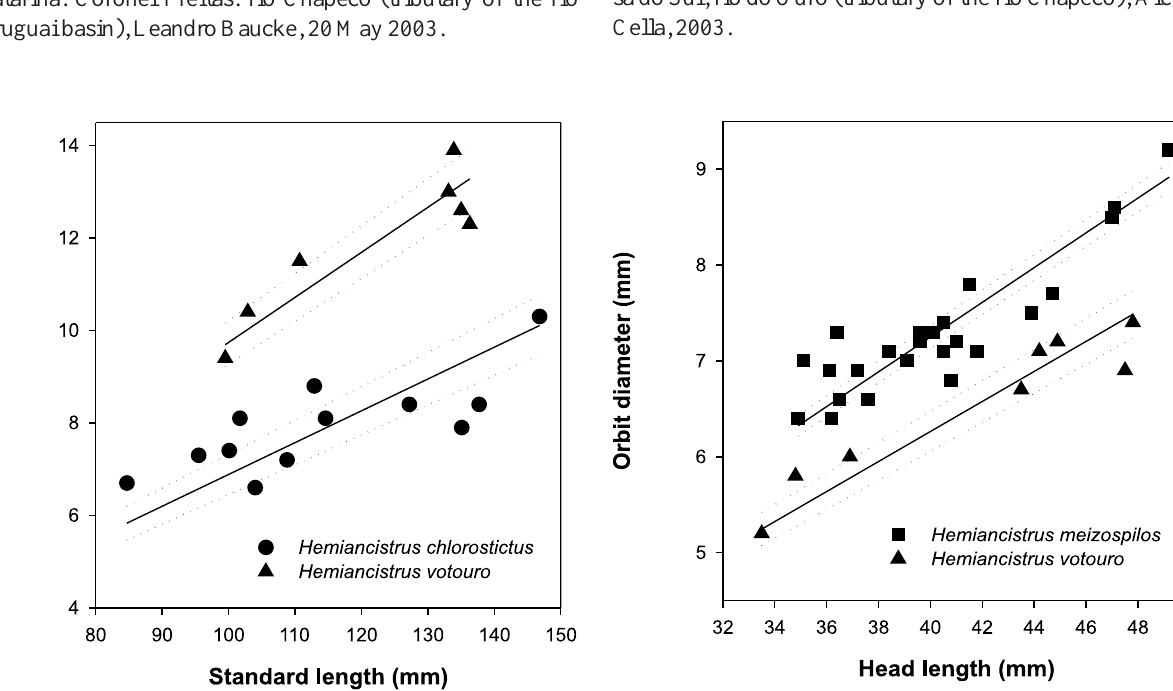
Fig. 4. Scatter plot and regression line of orbit diameter as a function of head length in Hemiancistrus votouro and H. meizospilos